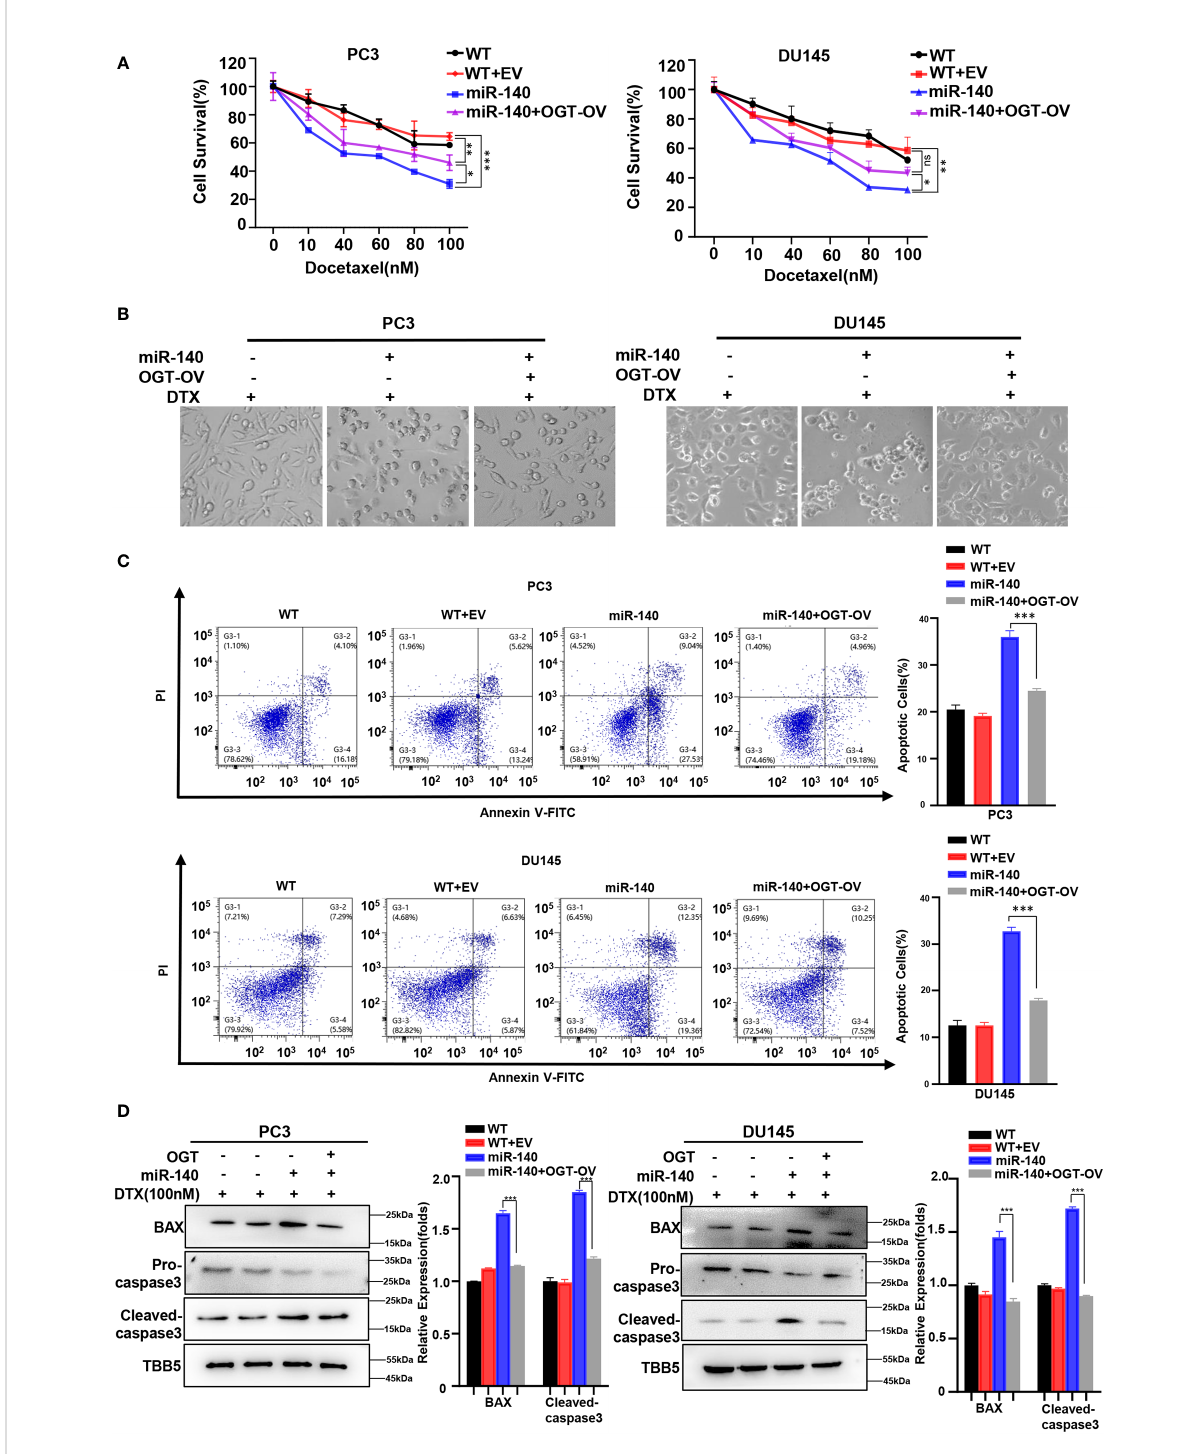
FIGURE 8 MiR-140-induce PC cells sensitization to DOCETAXEL is OGT dependent. (A) CCK8 revealed that overexpression of miR-140 enhanced the sensitivity of cells to docetaxel, which was rescued by overexpression of OGT. (B) Morphological analysis of different treated PC3 and DU145 cells. (C) MiR-140 increased docetaxel-induced cell apoptosis, which was rescued by overexpression of OGT. (D) Western blot(WB) analysis of BAX and caspase-3 levels in PC3 and DU145 cells overexpressing OGT with